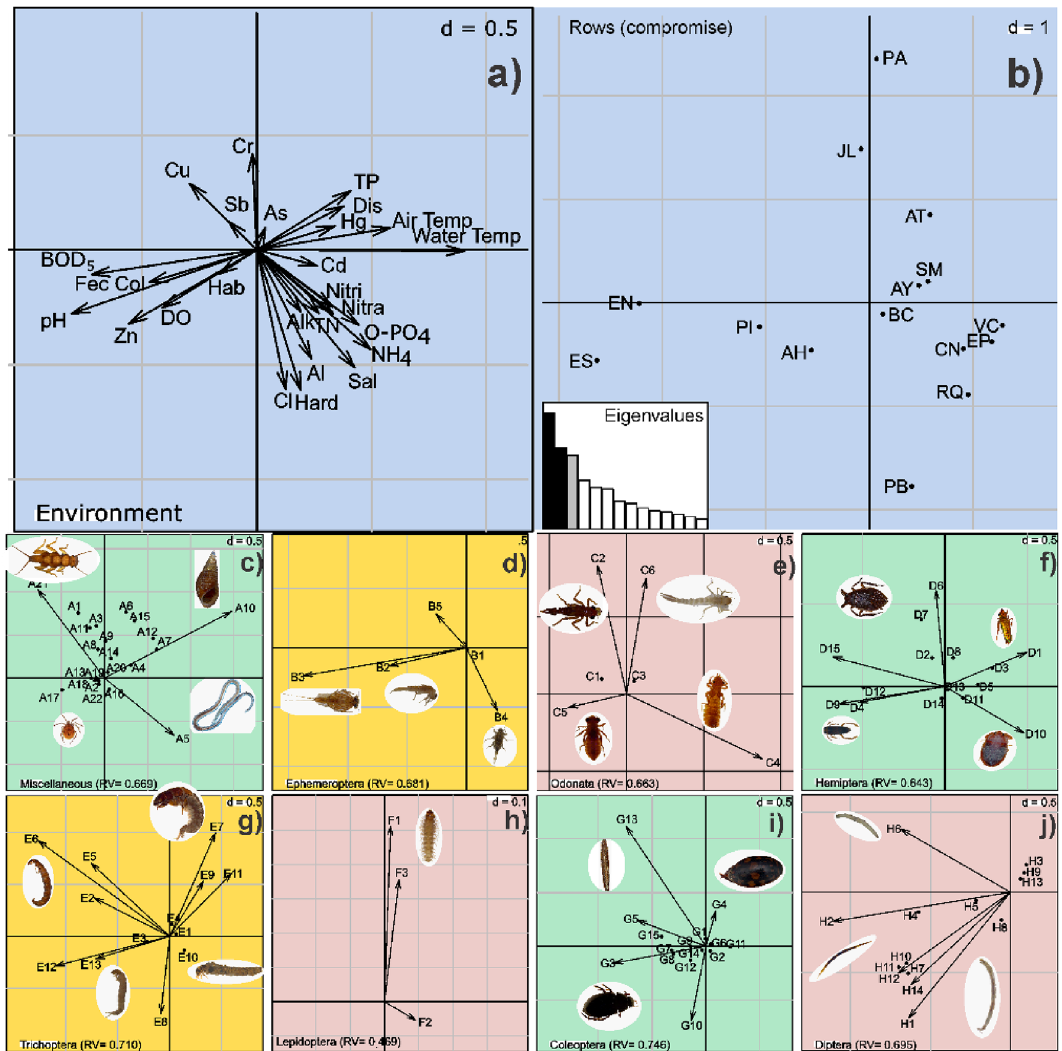
Figure 3. Results of the MCOA: (a) environmental factors resulting from the correlation analysis. Vectors indicate the magnitude of each factor over each taxa block; (b) ordered study sites; (c–j) blocks of contribution (vectors) of aquatic macroinvertebrate taxa (for easier visualization, separate biplots are shown for each taxonomic order). See Appendix for taxa codes. The blocks and MCOA analysis were generated using the ADE4 package (https:// cran.r- proje ct. org/ web/ packa ges/ ade4/ index. html; Dray, S. & Dufour, A.-B. 2007. The ade4 Package: Implementing the Duality Diagram for Ecologists) and vegan package (http:// cran.r- proje ct. org/; Oksan en, J., Kindt, R., Pierre, L., O’Hara, B., Simpson, G. L., Solymos, P., … Wagner, H. 2016. Vegan: Community Ecology Package, R package version 2.4–0). Images were edited using Inkscape, an open source